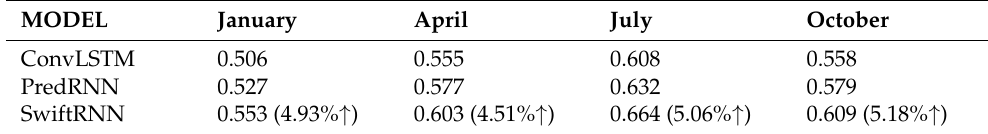
Table 7. Same with Table 5, but for CSI-10000